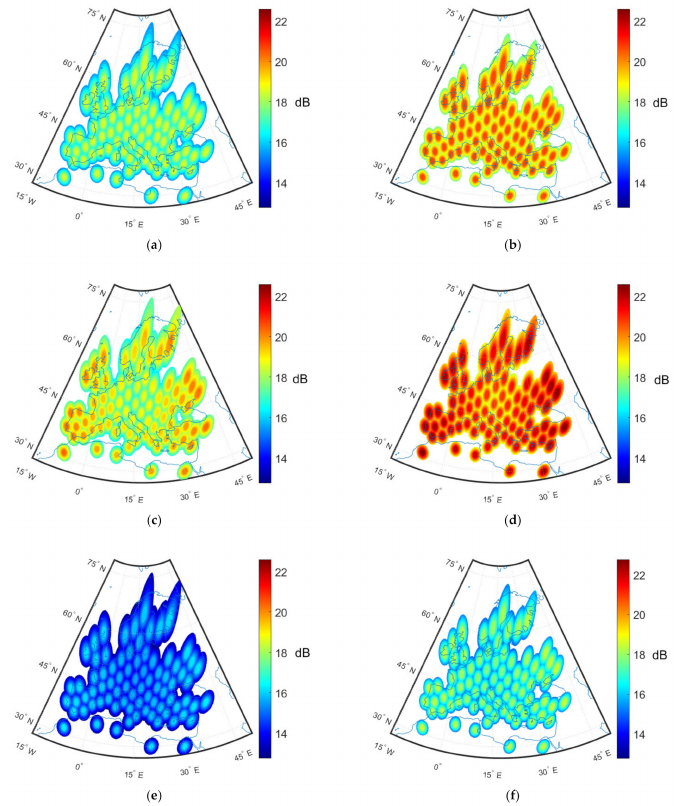
Figure 6. CNR (Carrier to Noise Ratio), CIR (Carrier to Interference Ratio), and CINR (Carrier to Interference plus Noise Ratio) geographical maps in dB for the KaSat coverage and same number of beams but different beamwidths. ( a ) CNR in dB using θ 3dB = 0.65 ◦ . ( b ) CNR in dB using θ 3dB = 0.55 ◦ . ( c ) CIR in dB using θ 3dB = 0.65 ◦ . ( d ) CIR in dB using θ 3dB = 0.55 ◦ . ( e ) CINR in dB using θ 3dB = 0.65 ◦ . ( f ) CINR in dB using θ 3dB = 0.55 ◦